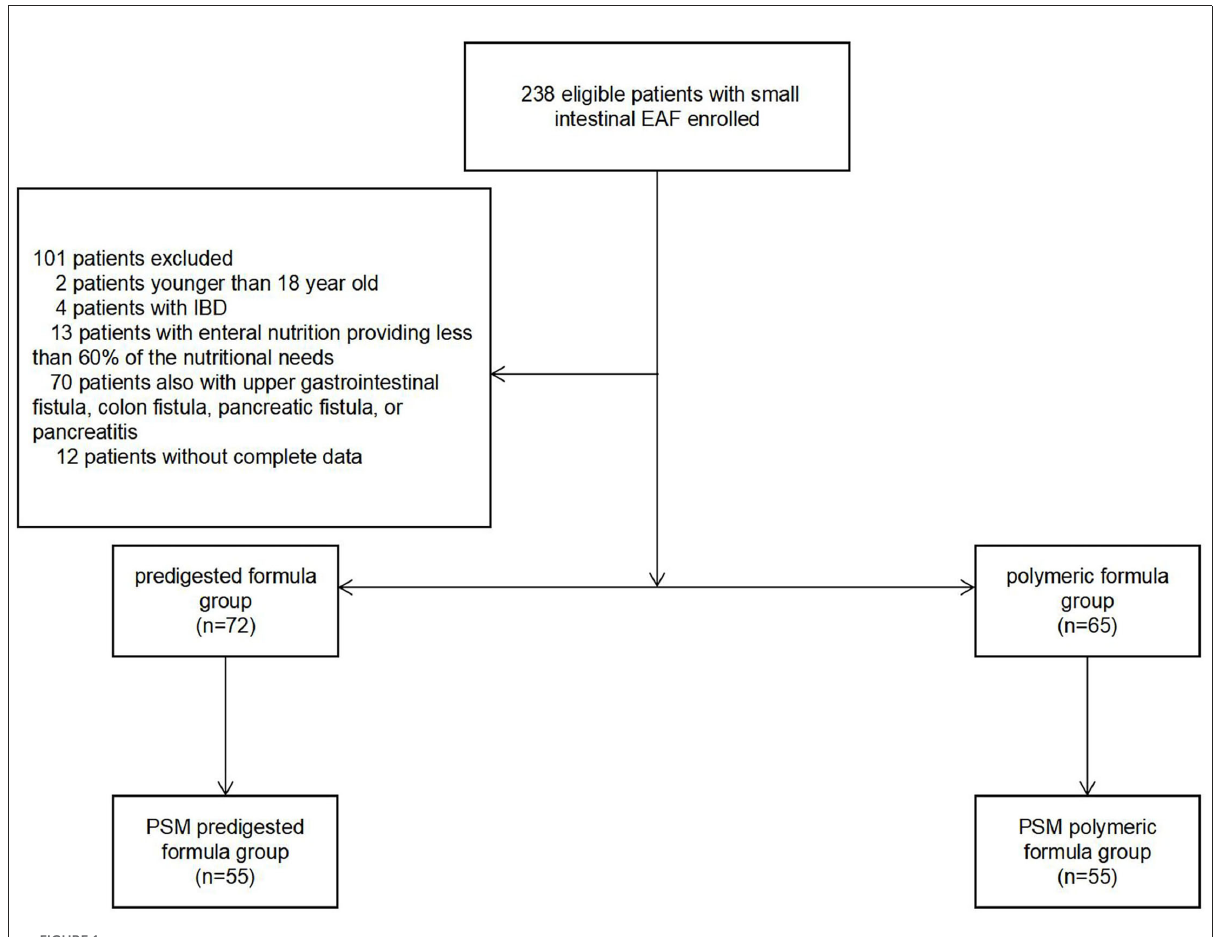
FIGURE1 The patients and